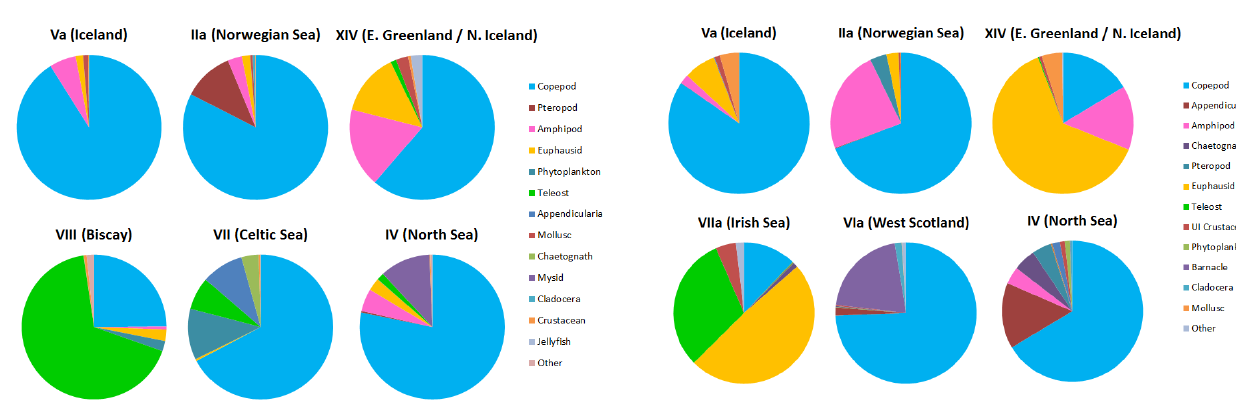
Figure 4. Diet composition of mackerel Scomber scombrus in dif- ferent parts of the northeast Atlantic (ICES Divisions). Proportions are based on the number of individual prey items.